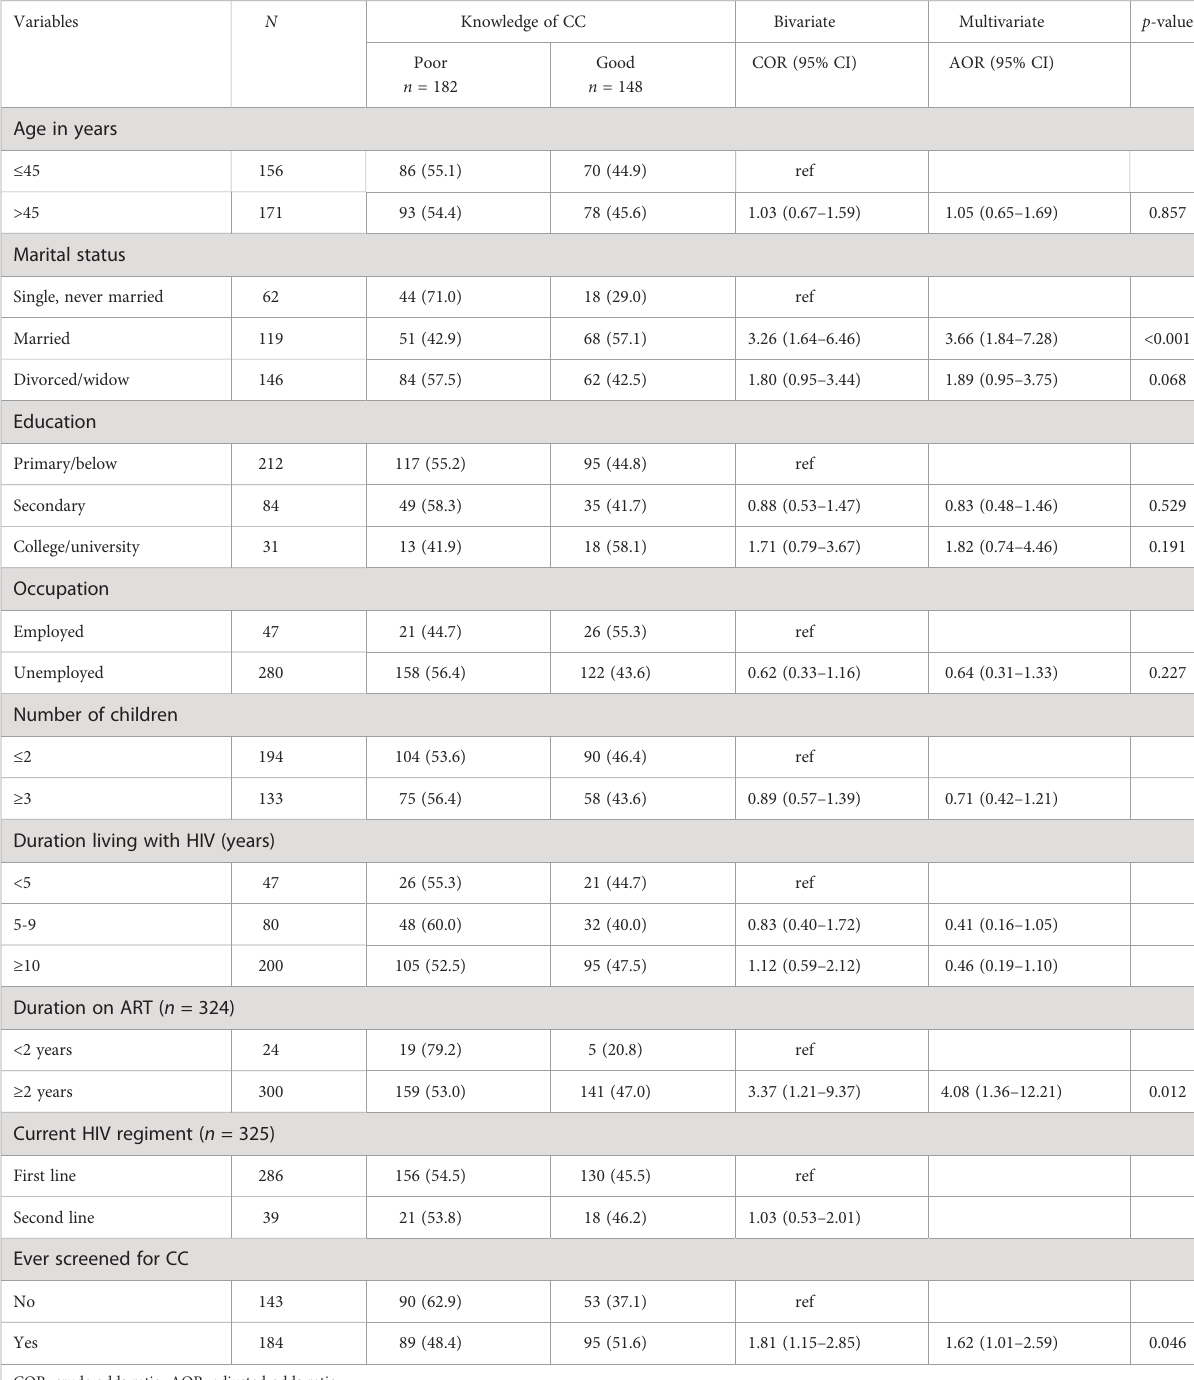
TABLE 4 Factors associated with knowledge of CC among women living with HIV ( N =